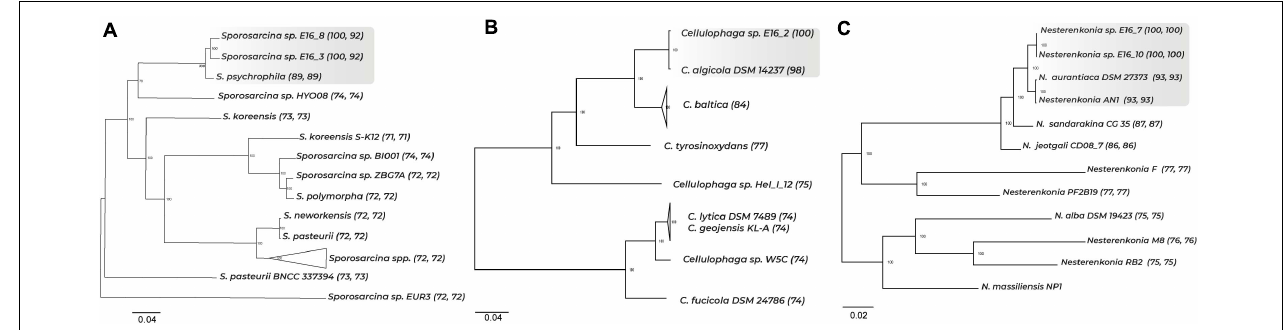
FIGURE 1 | Phylogenomic tree of core genes and ANI among representative Sporosarcina , Cellulophaga , and Nesterenkonia genomes. A total of 756, 355, and 190 core genes were used to perform the phylogenomic tree for Sporosarcina , Cellulophaga , and Nesterenkonia . ANI values are shown in parenthesis. In (A) , first and second ANI values correspond to comparison with Sporosarcina E16_8 and E16_3, respectively; in (B) , ANI value corresponds to comparison with Cellulophaga E16_2, and in (C) , first and second ANI values correspond to comparison with Nesterenkonia E16_7 and E16_10,